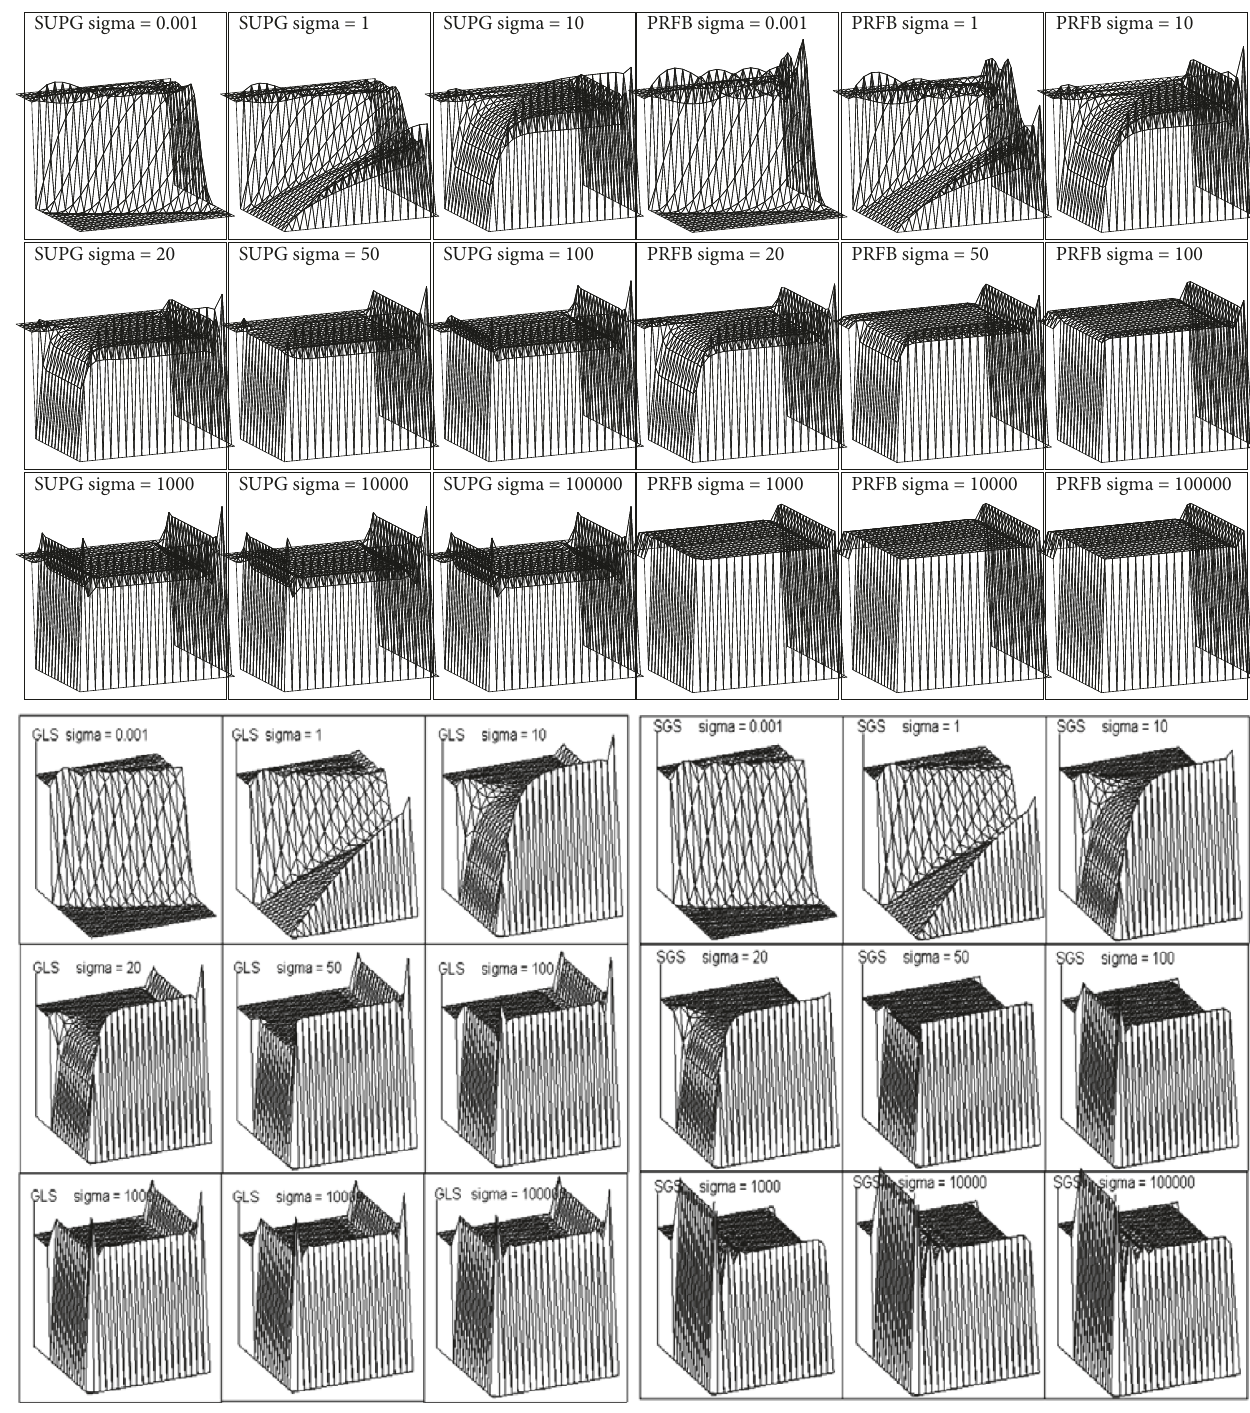
Figure 12: Numerical solutions for 𝜃 = 72 ∘ , 𝜖 = 10 −4 , and 𝑁 = 20